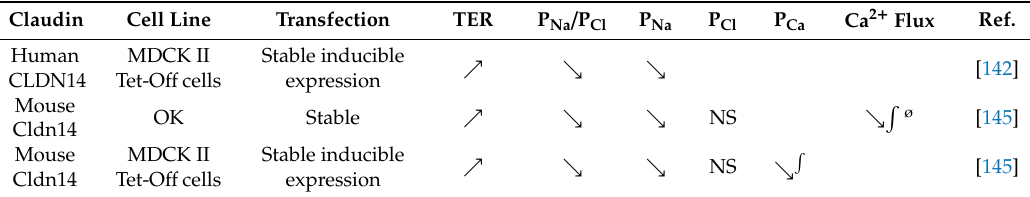
Table 8. Function of claudin 14 according to heterologous expression studies in cell lines. Claudin